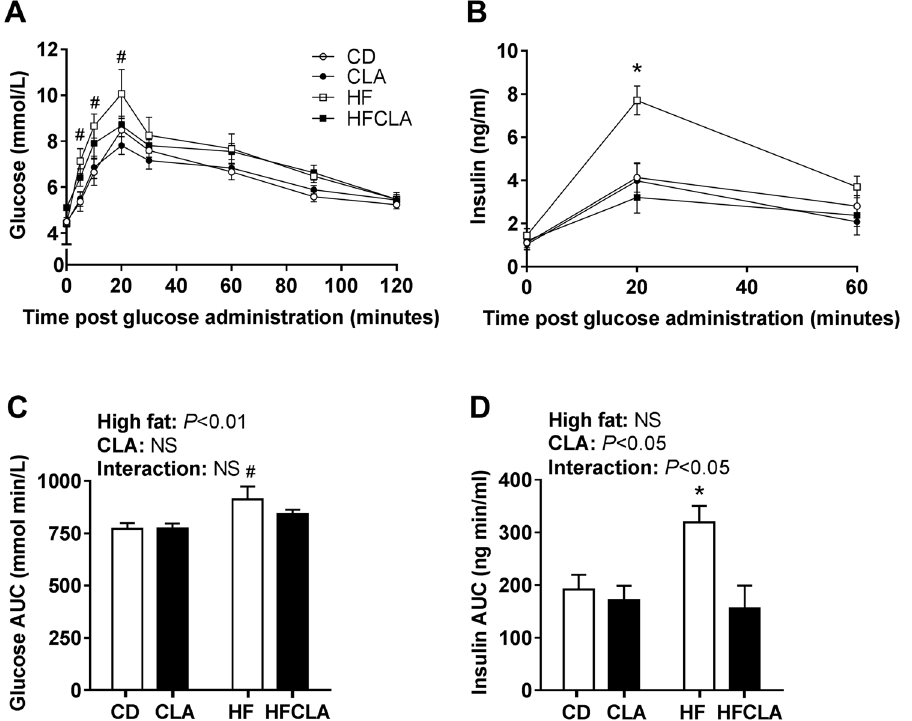
Figure 3. Offspring oral glucose tolerance tests. (A) Glucose concentrations and (B) plasma insulin concentrations after oral administration of glucose. (C) Glucose area under the curve and (D) insulin area under the curve. Data expressed as means ± SEM ( n = 5–6 litters/group), where # P < 0.05 vs CD and CLA and * P < 0.05 vs all other